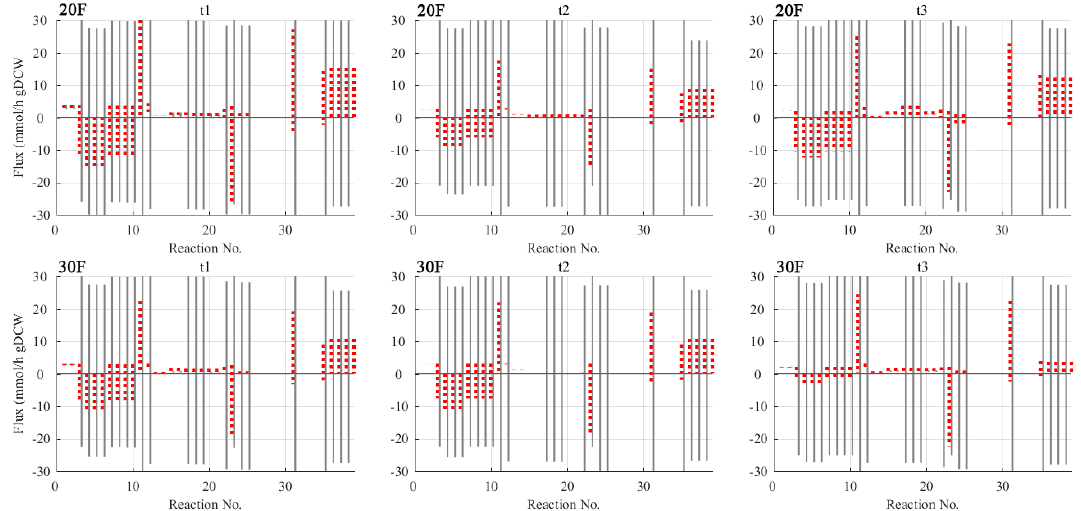
Figure 3. Ranges of 39 intracellular fluxes predicted by TBFE (dotted line) and flux variability analysis (FVA) (grey line) using sampled extracellular fluxes from t 1 , t 2 and t 3 (20F and 30F).